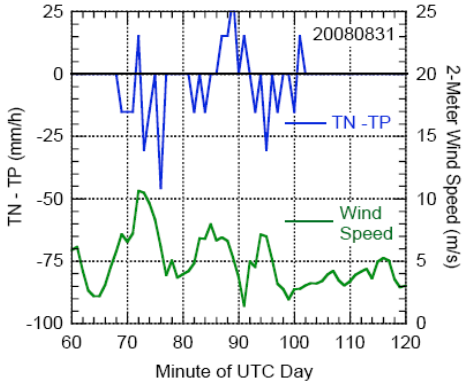
Fig. 12 One-minute rain rate differences TN-TP and 2-m wind speed for the event in Fig. 9.